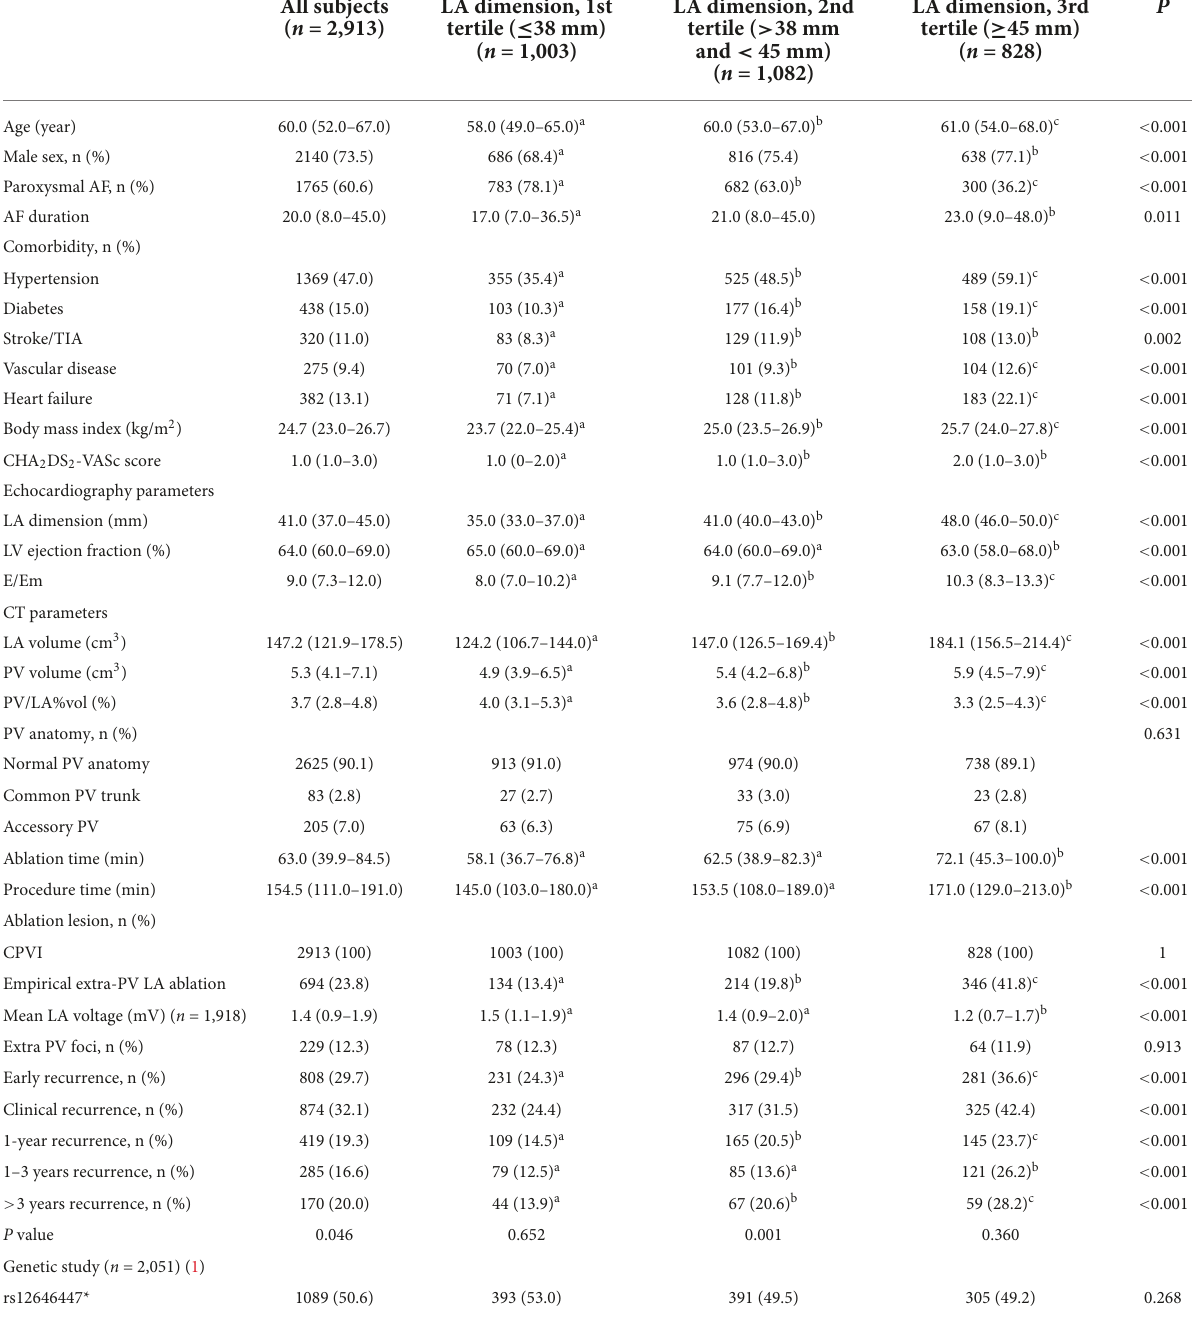
TABLE 1 Baseline characteristics among the three groups according to the tertile value of LA